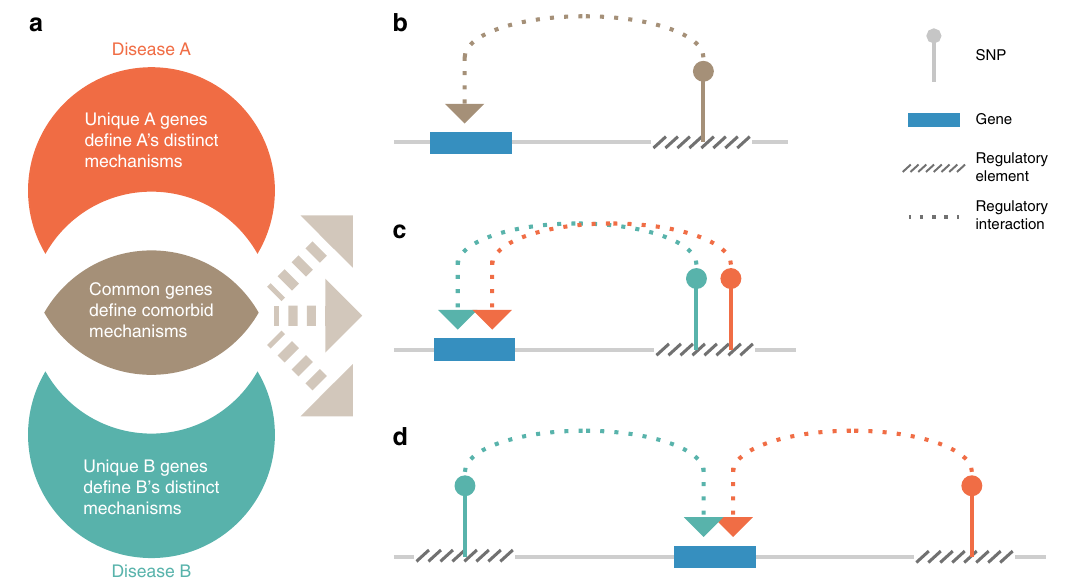
Fig. 7 Schematic model of gene pleiotropy in multimorbidities. a Common target genes between any two complex disorders highlight the molecular mechanism(s) that underlie their common pathogenicity. The sets of target genes that are unique to the disorders represent the mechanisms that make the disorders different. Gene pleiotropy in multimorbidities of complex disorders can occur when b a variant associated with the disorders marks a regulatory element that target the common gene; c different variants associated with different disorders mark the same (super)-regulatory element that impacts the common gene; or d different regulatory elements marked by different variants impact the common